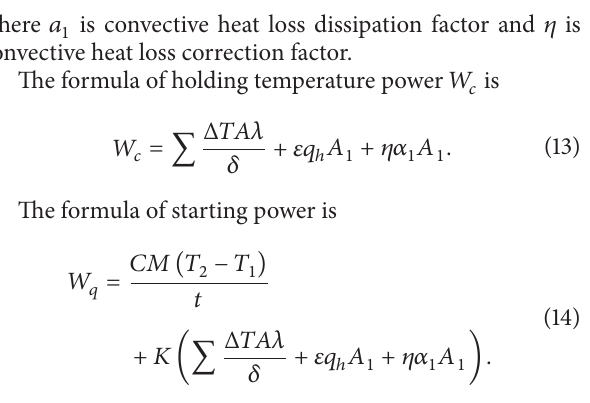
3.2.2. Power Analysis of Hot-Rolling-Head. The heat require- ment of the hot-rolling-head is start-up and holding temper- ature power. Start-up power 𝑊 𝑞 is used for heating roller to change room temperature 𝑇 1 to the required temperature 𝑇 2 . 𝑊 𝑞 is composed of heating power and distribute